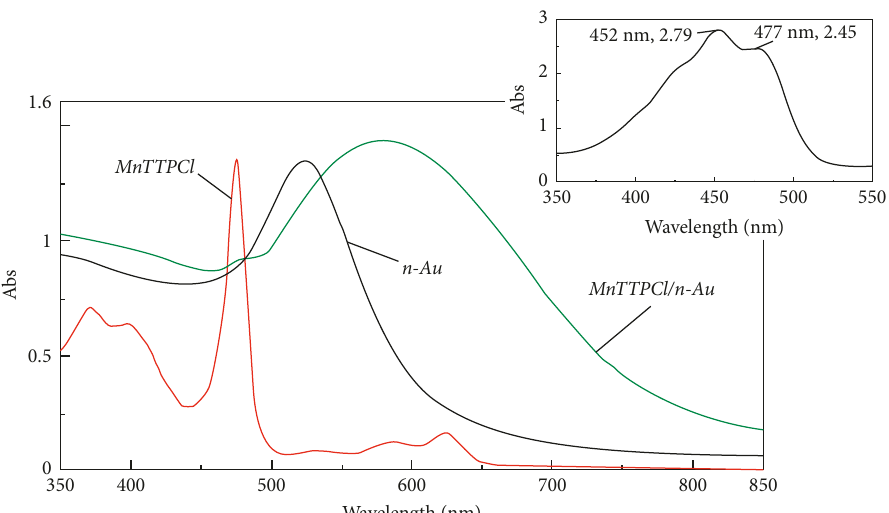
4 M) in 5 10 (cid:31) × −